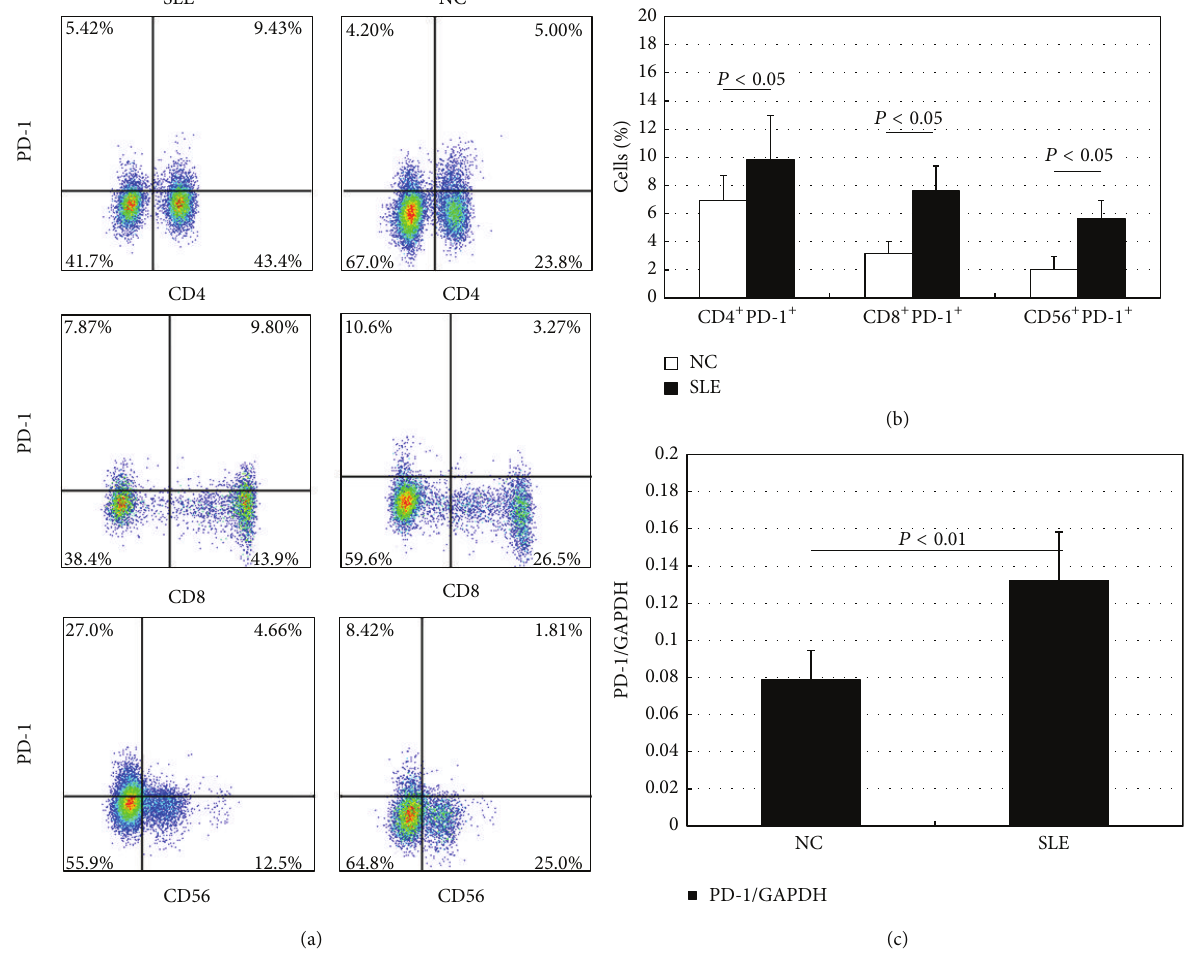
Figure 1: Increased basal programmed death 1 (PD-1) expression in PBMCs from SLE patients. (a) Representative flow cytometry analysis of PD-1 expression on CD4 + , CD8 + , and CD56 + T cells in SLE patients and normal healthy controls (NC); (b) upregulated expression of PD-1 on CD4 + , CD8 + , and CD56 + T cells from SLE patients, as compared with those from NC; (c) mRNA expression of PD-1 in PBMCs from SLE patients. Horizontal bars indicate the mean ±